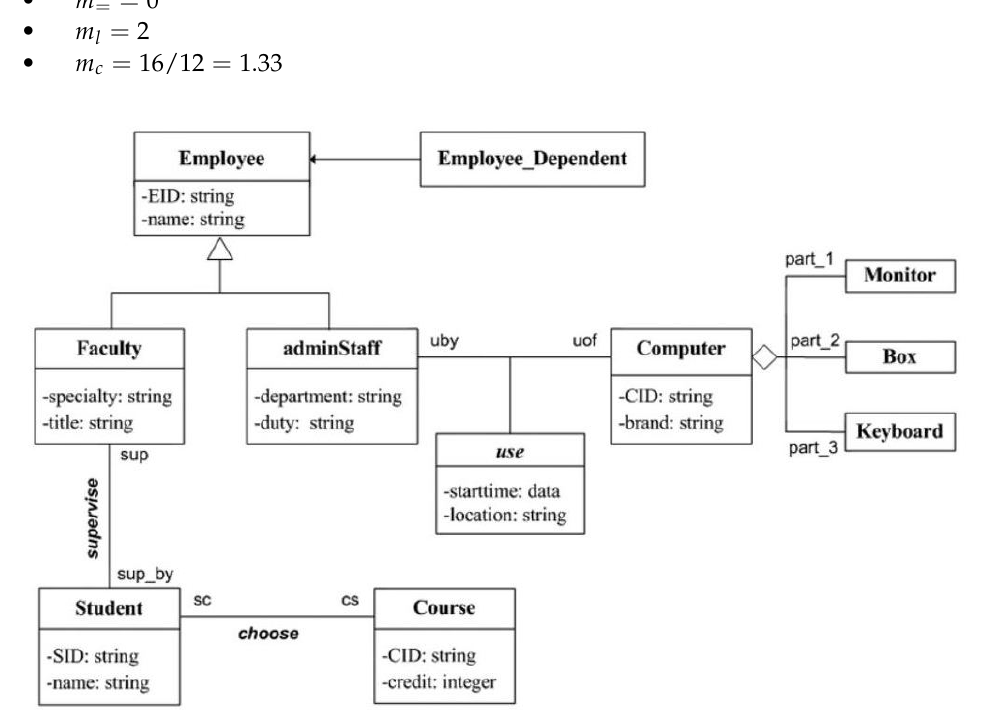
Figure 2. UML class diagram of a university (source: